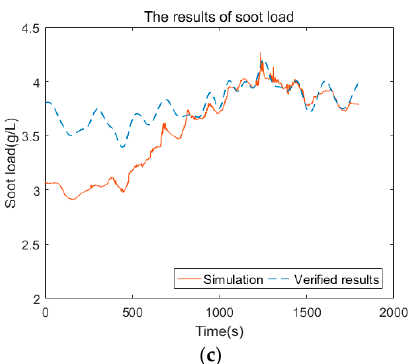
Figure 6. The results of the soot load with an incorrect initial value: ( a ) Soot load of the 4th cycle; ( b ) Soot load of the 15th cycle; ( c ) Soot load of the 20th cycle.